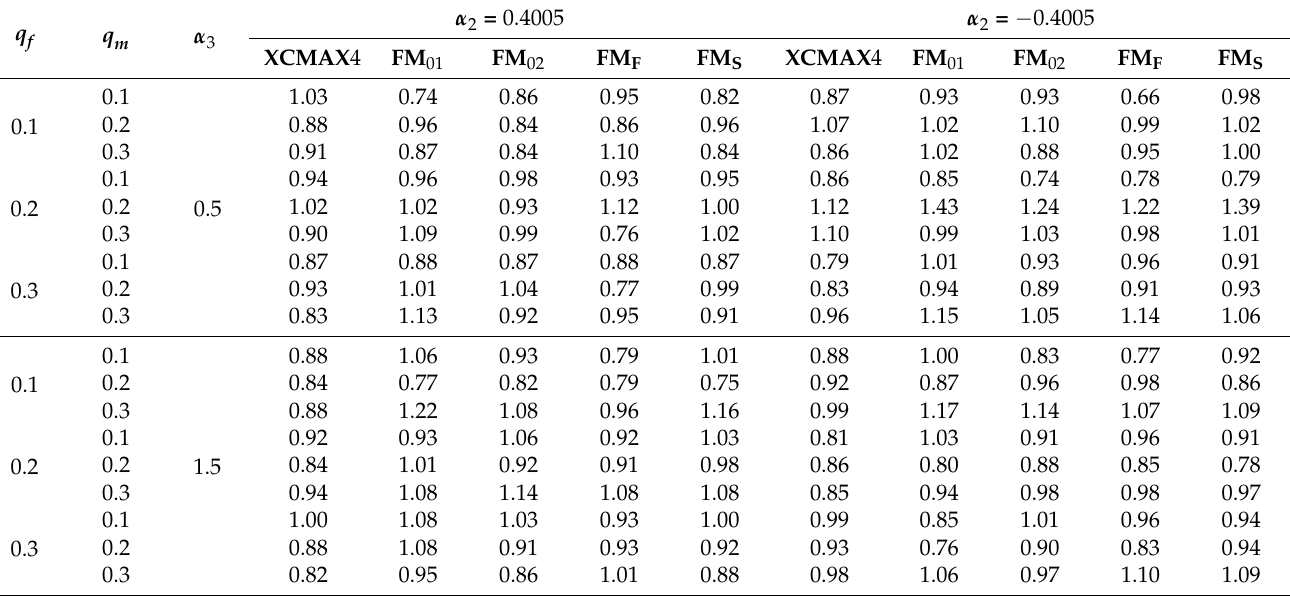
Table 2. Estimated type I error rate FM 01 , FM 02 , FM F , and FM S against q f , q m , α 2 , and α 3 based on 1,000,000 replicates under